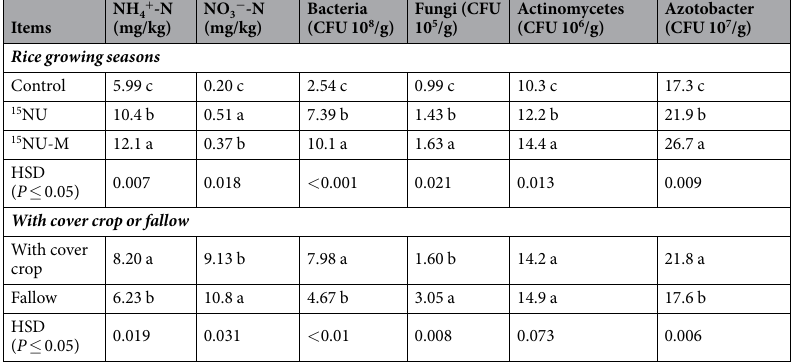
Table 4. The inorganic N contents and populations of microbes in the top paddy soil of legume-rice rotation system. 15 NU: 15 N-labeled urea as FN alone, 15 NU-M: substituting partial 15 N-labeled urea with CMV as GM. Different letters within the same column indicate significant differences among treatments according to Tukey’s test at P ≤